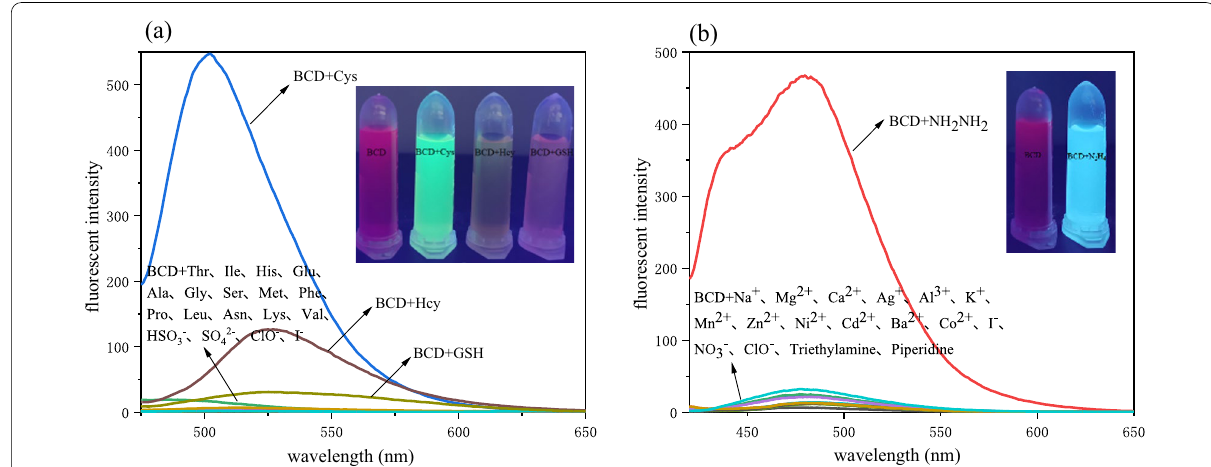
Fig. 11 a Fluorescence spectra of probe BCD (60 µM) in the presence of other species (1 mM) in the DMF-Hepes buffer (8/2, v/v, pH λex 463 nm. Inset: color of the solution containing BCD (60 µM) before and after the addition of Cys(1.4 mM), Hcy(1.4 mM), GSH (1.4 mM) in = the DMF-Hepes buffer (8/2, v/v, pH 7.4) under 365 nm UV light. b Fluorescence spectra of probe BCD (60 µM) in the presence of other species = (400 µM) in the DMF-Hepes buffer (7/3, v/v, pH 7.4), λex 407 nm. Inset: color of the solution containing BCD (60 µM) before and after the = = addition of N 2 H 4 (10 mM) in the DMF-Hepes buffer (7/3, v/v, pH 7.4) under 365 nm UV =